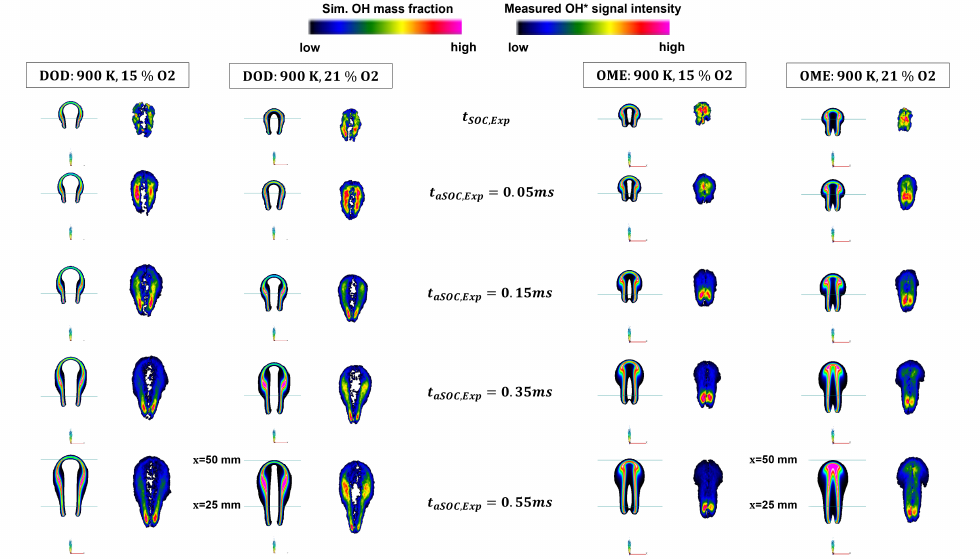
Figure 13. Conti3L ( Ar ): OH flame shape in center plane: Simulation vs experiment. ( left ) Dodecane. ( right ) OME.